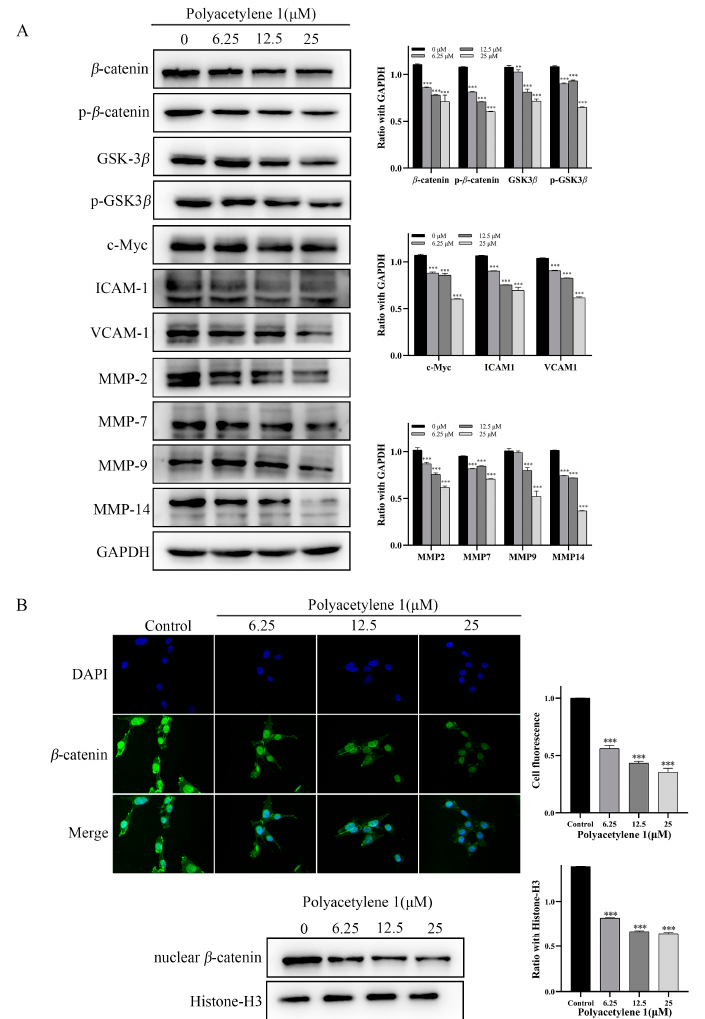
Figure 7. Effects of polyacetylene 1 on the Wnt/ β -catenin signaling pathway in HGC-27 cells. ( A ) Western blot results of Wnt/ β -catenin signaling pathway-related proteins in total lysates of HGC-27 cells treated with 25, 12.5, and 6.25 µM of polyacetylene 1 for 24 h. GAPDH was used to ensure an equal amount of loaded protein. ( B ) Immunofluorescence images and Western blot results